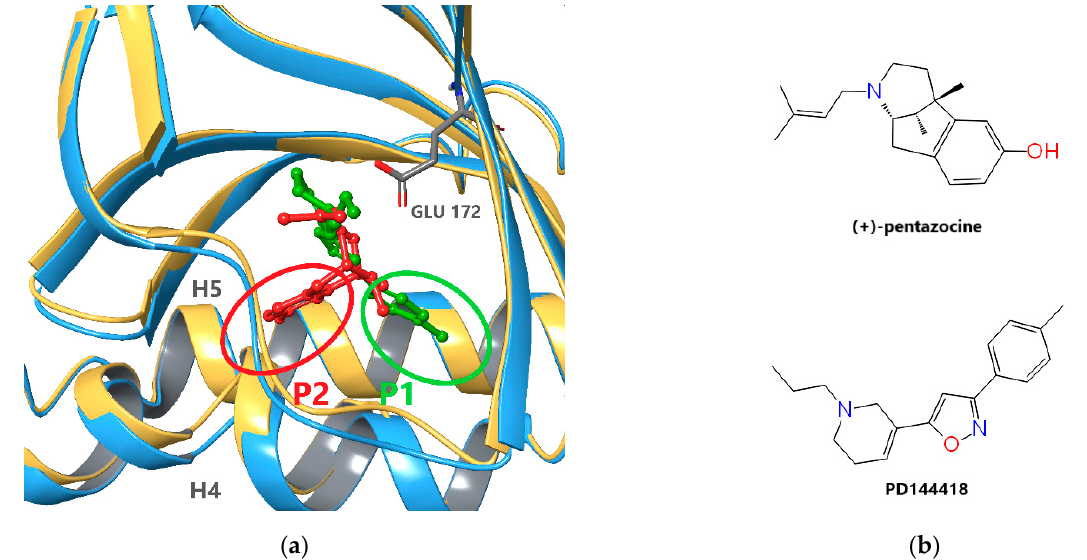
Figure 1. Ligand binding of S1R: ( a ) Superposition of agonist- ((+)-pentazocine, red) and antagonist-(PD144418, green) bound S1R monomers (PDB IDs: 6DK1 chain C (blue) and 5HK1 chain A (gold)). Backbone atoms of residues 170–176 and 197–217 were used if fitting. PD144418 and (+)-pentazocine occupy two different subpockets, P1 and P2, between the C-terminal helixes H4 and H5. ( b ) Chemical structure of ligands (+)-pentazocine and PD144418.